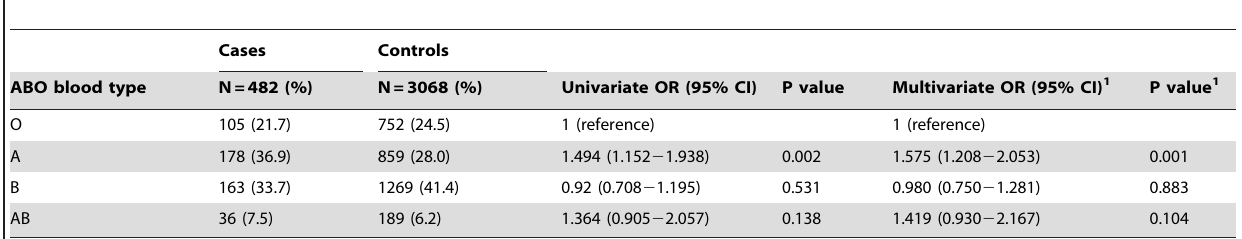
Table 2. The association between cutaneous malignant melanoma risk and ABO blood types: Univariate and multivariate logistic regression analyses.